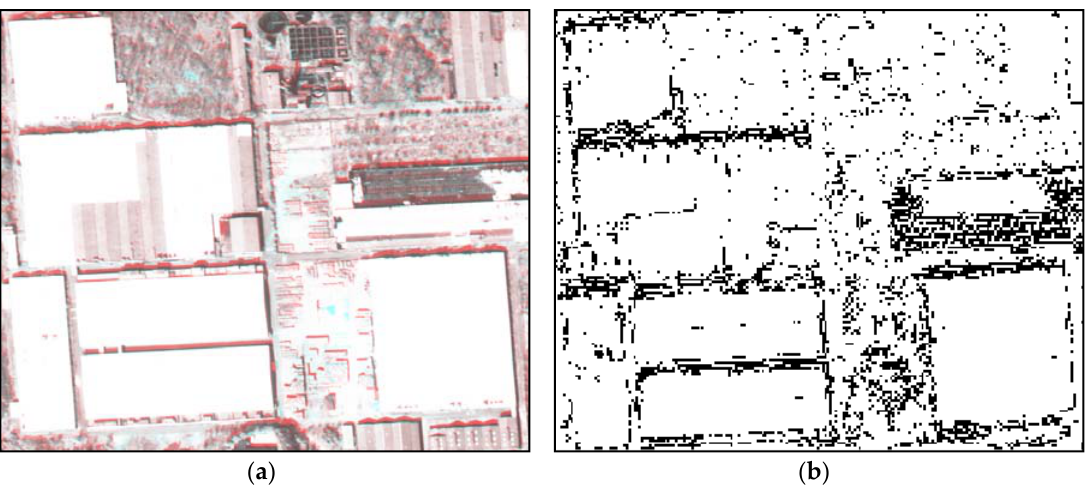
Figure 7. An example of an RN extraction result: ( a ) georegistered multi-temporal images and ( b ) extracted RN from the images.